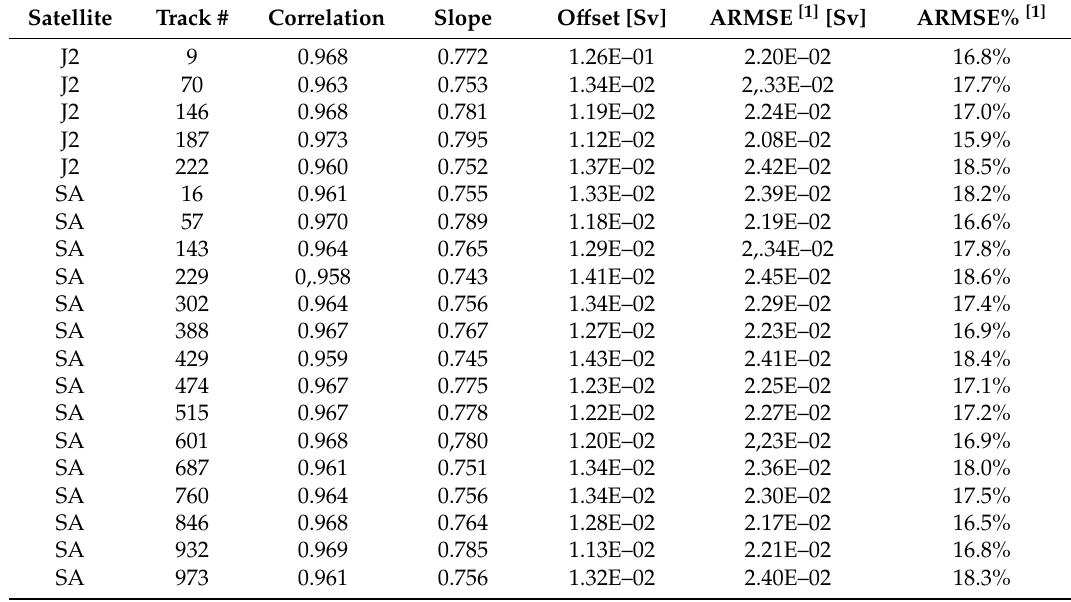
Table 2. Statistical scores and fit parameters for each track in the simulated application of the Random Forests